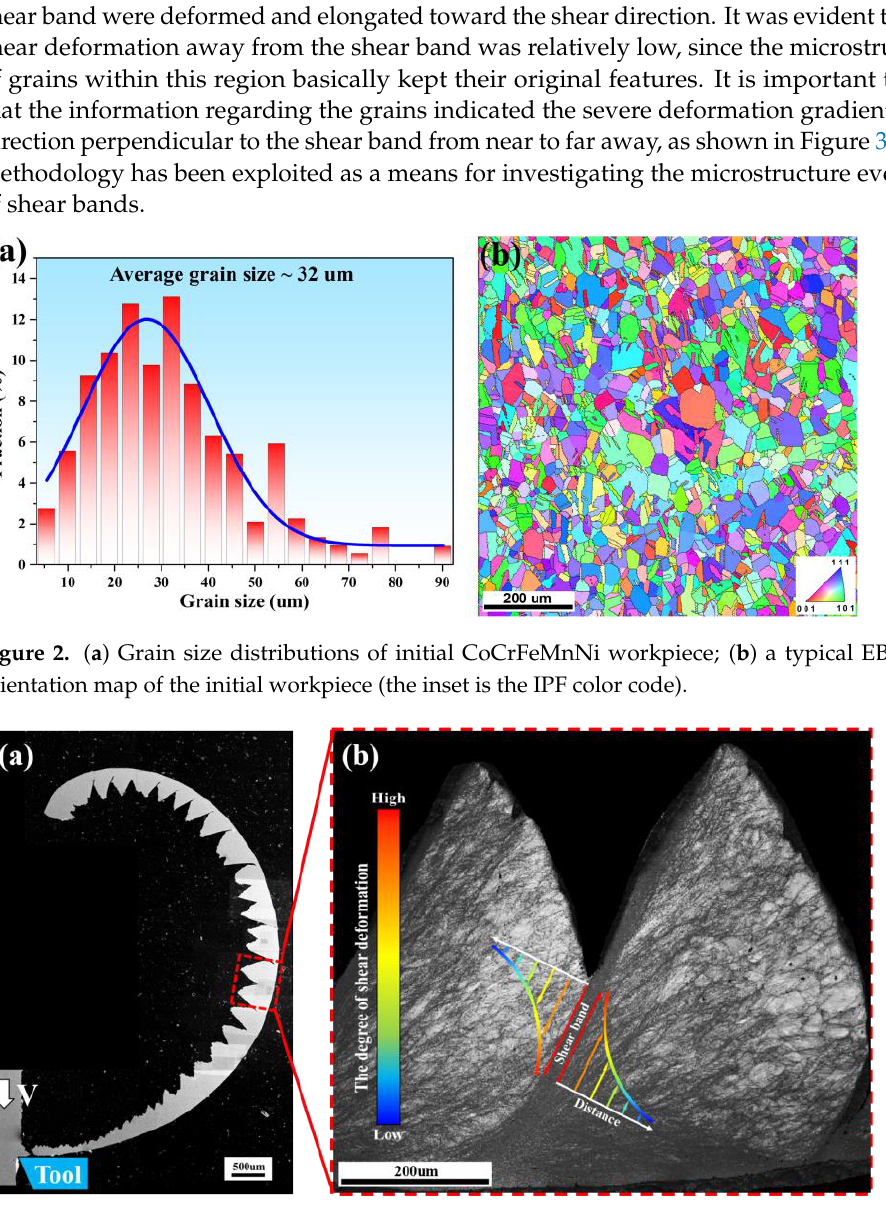
Figure 3. The microstructure of serrated chip formation at cutting speed of 15 m/s: ( a ) the morphol- ogy of chip from SEM; ( b ) EBSD image quality (IQ) map of shear band in the serrated chip.